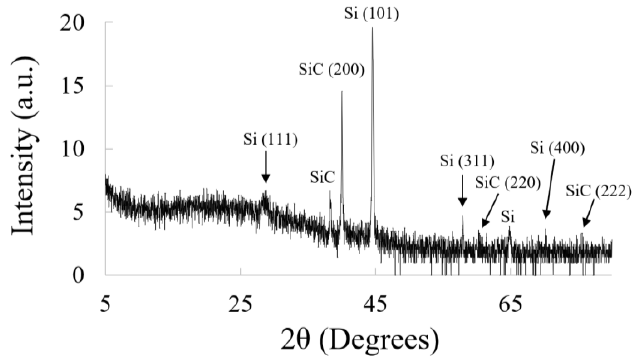
Figure 3. X-ray diffraction spectra for a Si/SiC multilayer on silicon substrate where 2θ is the diffraction angle and the intensity is shown in counts per second (cps).